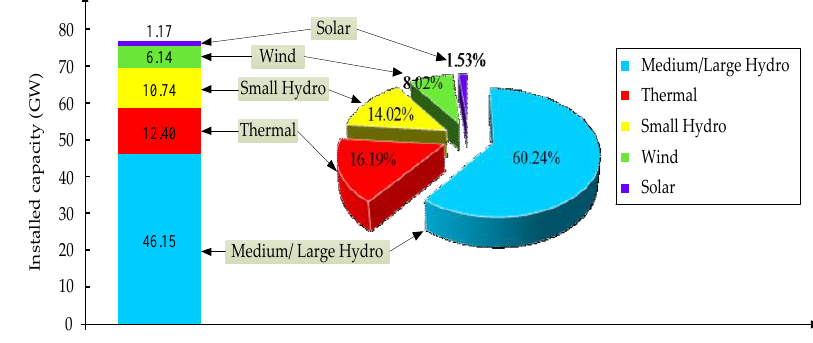
Figure 4. The installed capacity mix of Yunnan at the end of 2015.